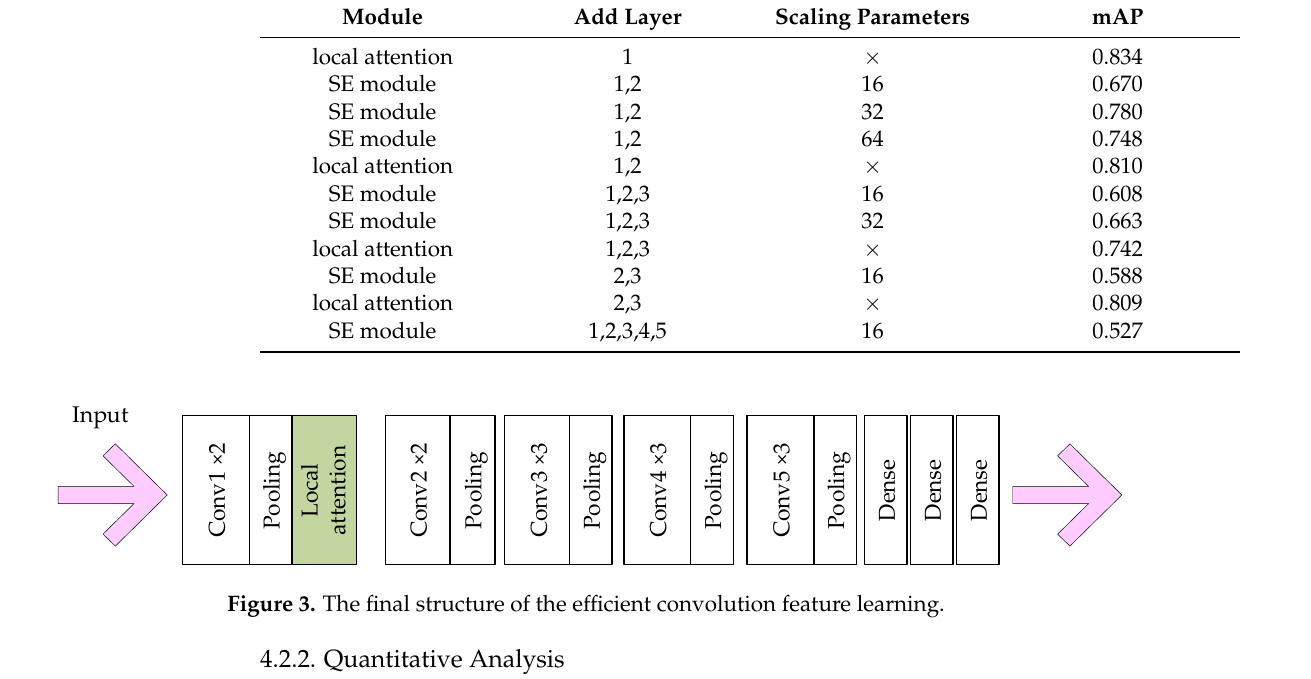
Table 2. Experiments on the locations of the added SE module and local attention.